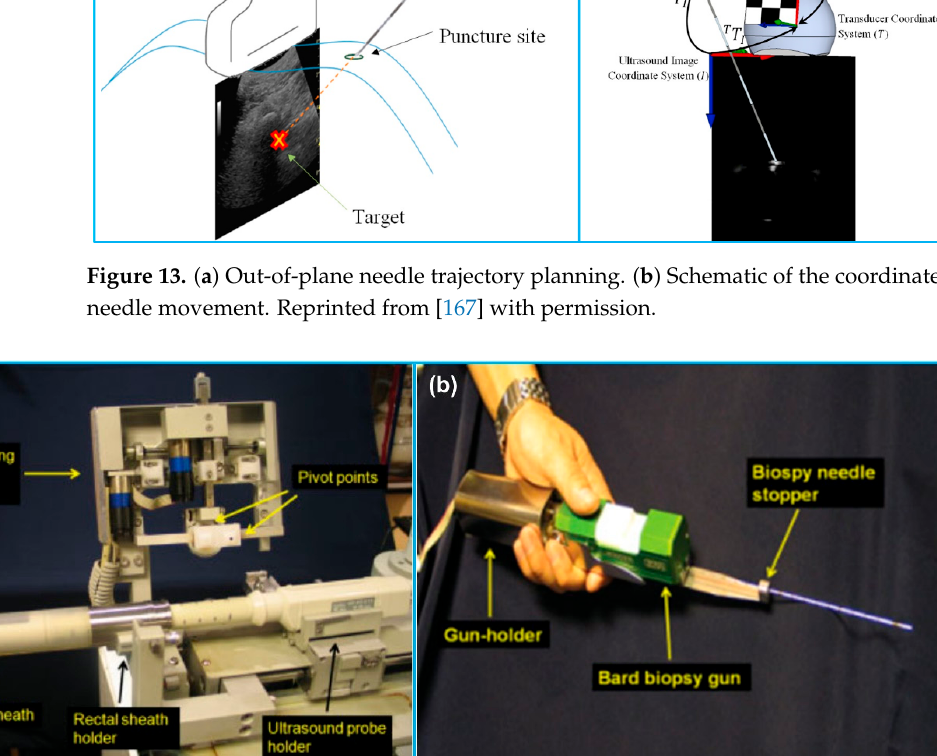
Figure 14. A robotic US-guided prostate intervention system. ( a ) Gantry and US probe holder. ( b ) Figure 13. ( a ) Out-of-plane needle trajectory planning. ( b ) Schematic of the coordinate systems and Gun-holder and biopsy gun. Reprinted from [169] with needle movement. Reprinted from [167] with permission.